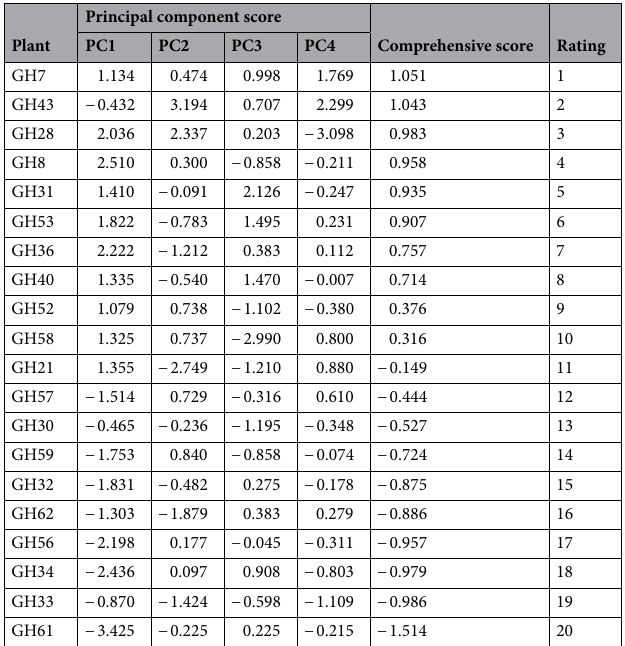
Table 5. Principal component score, comprehensive score and ranking of all superior strains of Wangmo red ball Camellia